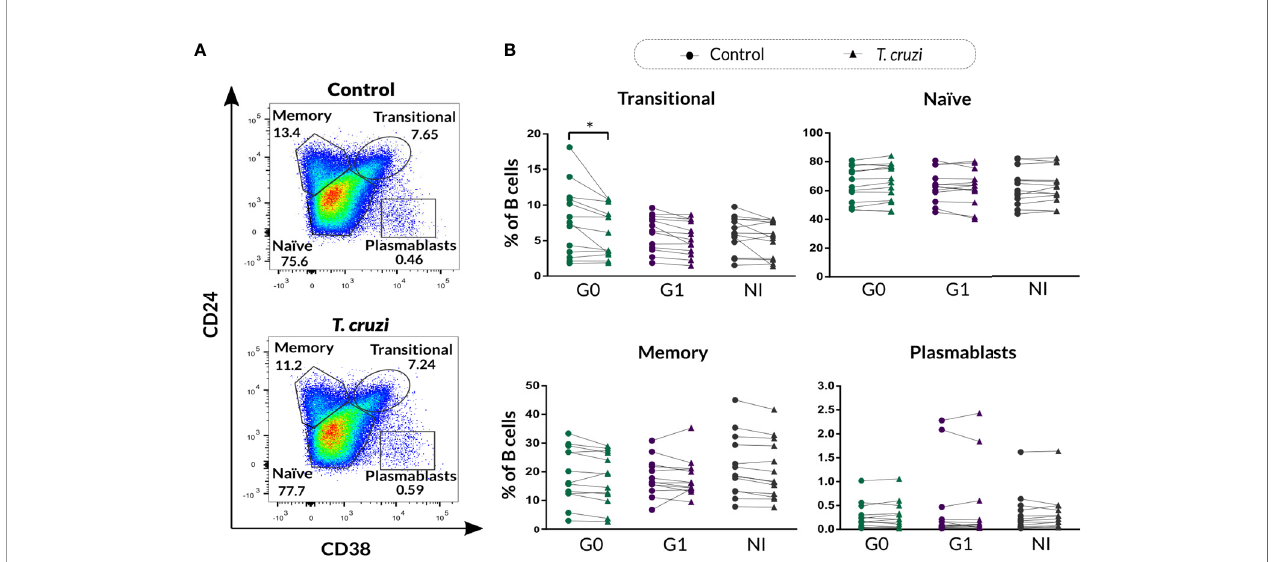
FIGURE 1 | Phenotypic distribution based on CD24 and CD38 expression of isolated B cells from patients with CCD and NI donors upon T. cruzi stimulation. (A) Gating strategy used to identify B cell subsets according to CD24 and CD38 expression. Dot plots from one NI donor are illustrated. (B) Frequency of transitional, naïve, memory, and plasmablasts subsets in Control or T. cruzi stimulated B cells from CCD patients (G0, G1) and NI donors. Each symbol represents data from one individual. Statistically signi fi cant differences are indicated with an asterisk (*) p <